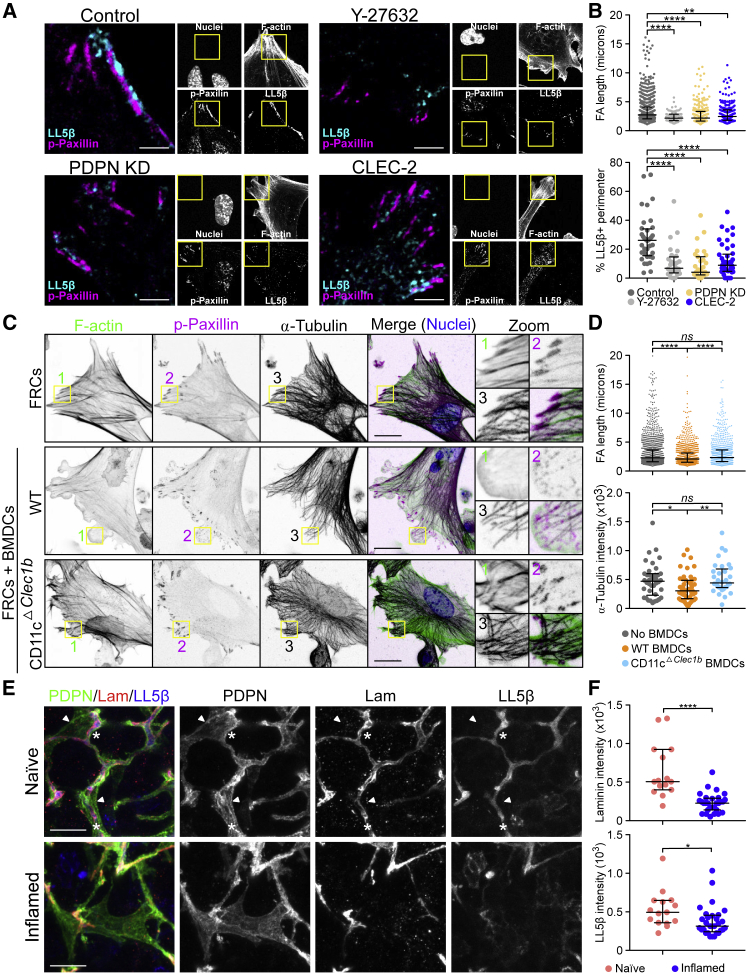
Focal Adhesion, Microtubule Organization, and Contractility in FRCs(A and B) Representative immunofluorescence of FCR cell lines untreated and control FRCs treated with Y-27632 ROCK inhibitor. (A) Maximum z stack projections of representative images are shown. Scale bars, 5 μm. (B) Quantification of FA length from p-paxillin staining and LL5β coverage as a percentage of the total perimeter. Dots represent FAs (top) or single cells (bottom) from 2 biological replicates. ∗∗p < 0.005, ∗∗∗∗p < 0.00005, one-way ANOVA, Tukey’s multiple comparisons test. Error bars represent SDs.(C) Immunofluorescence of FRC/DC cocultures control or CD11cΔCLEC-2 BMDCs. Maximum z stack projections. Scale bars, 20 μm.(D) Quantification of FA length and α-tubulin intensity in the cortical area (10 μm from the edge). Dots represent FAs (top) or single cells (bottom) from 3 biological replicates. ∗p < 0.05, ∗∗p < 0.005, ∗∗∗∗p < 0.00005, one-way ANOVA, Tukey’s multiple comparisons test. NS, not significant. Error bars represent SDs.(E) Representative immunofluorescence of cryosections of naive and inflamed LNs immunized with IFA/OVA. Maximum z stack projections. Scale bars, 20 μm. Asterisks and arrowheads indicate conduit-associated and conduit-independent surfaces, respectively, of FRCs.(F) Quantification of the indicated conduit components within the PDPN network. Each dot represents the median gray intensity of a different region of interest from 5 biological replicates. Error bars represent means and SDs. ∗p < 0.05, ∗∗∗∗p < 0.00005, unpaired t test.